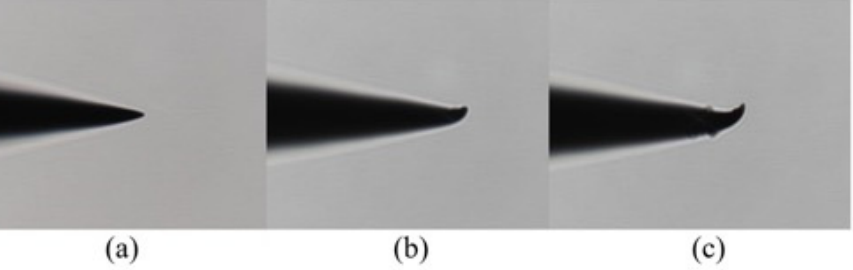
Figure 12. Experimental results of the dissecting needle tip wear: ( a ) Unused needle tip; ( b ) wear condition of tip of the microdissection device with flexure mechanism; ( c ) wear condition of tip of the microdissection device with the traditional mechanism.